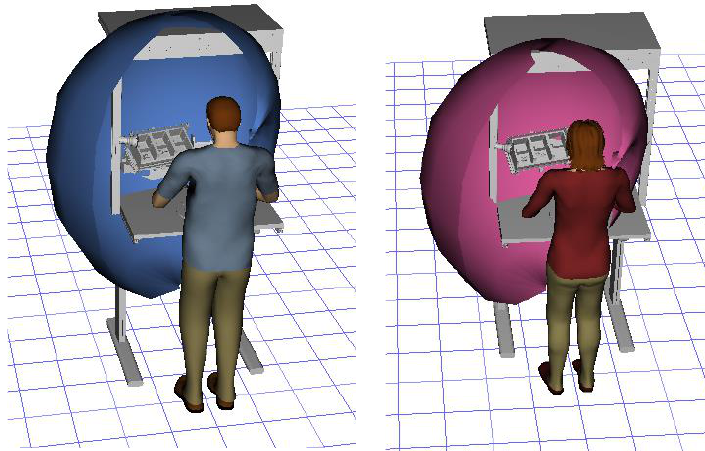
Figure 4. Reach analysis for male ( left ) and female ( right ) worker.